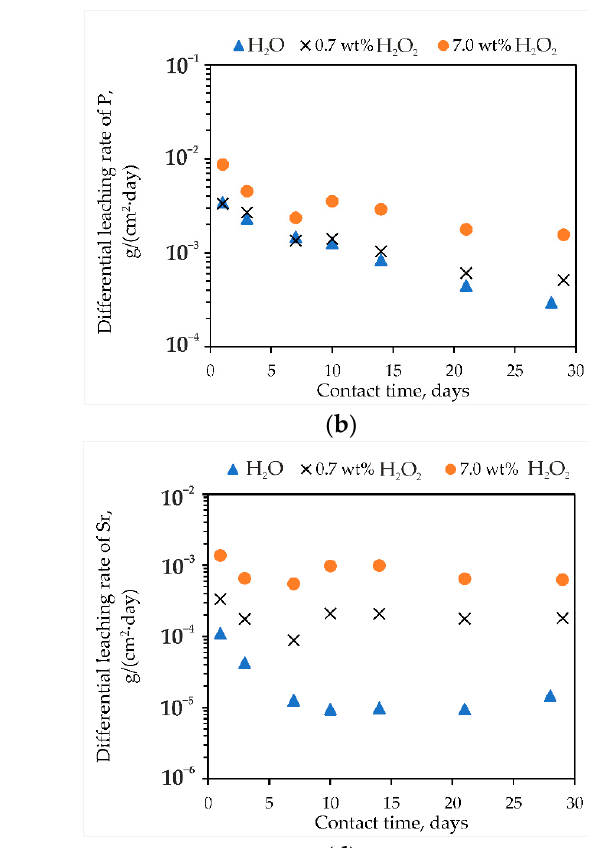
Figure 6 . Kinetic curves of the leaching rates of ( a ) Mg, ( b ) P, ( c ) K, and ( d ) Sr from MPP-Z com- pound after its heat treatment at 180 °C as a function of the hydrogen peroxide content in the contact solution.